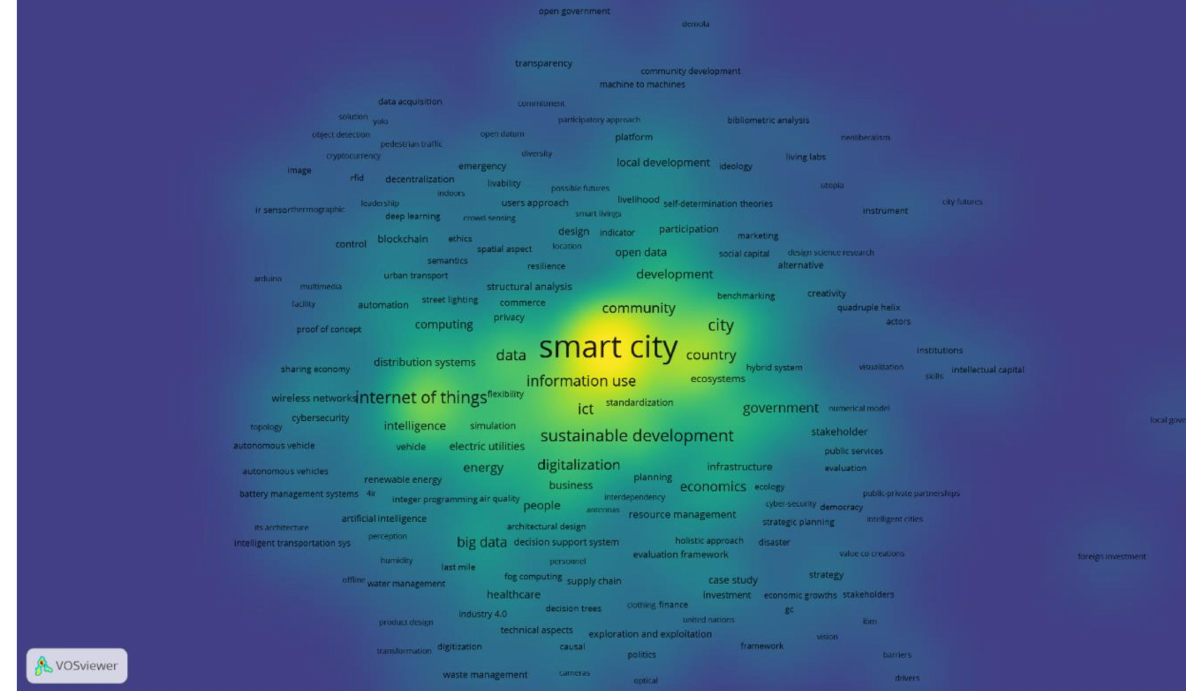
Figure 13. Item density